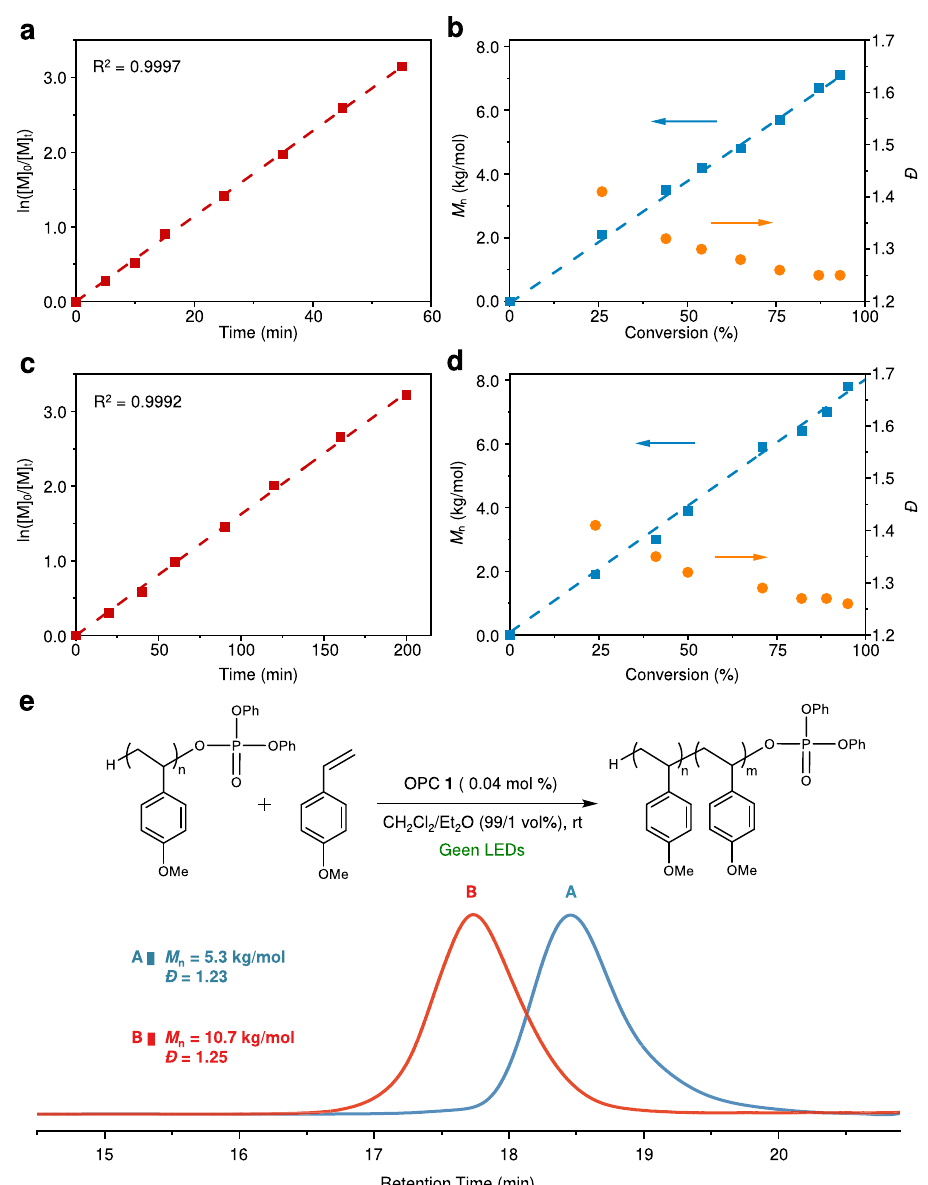
Fig. 4 Kinetic study of the photo-induced polymerization. a and c plots of ln([M] 0 /[M] t ) vs. reaction time (red squares) using 2a and 2b as CTA, respectively. b and d M n (blue squares) and Đ (orange circles) of poly( p -MOS) using 2a and 2b as CTA, respectively. e GPC traces of sequential monomer addition